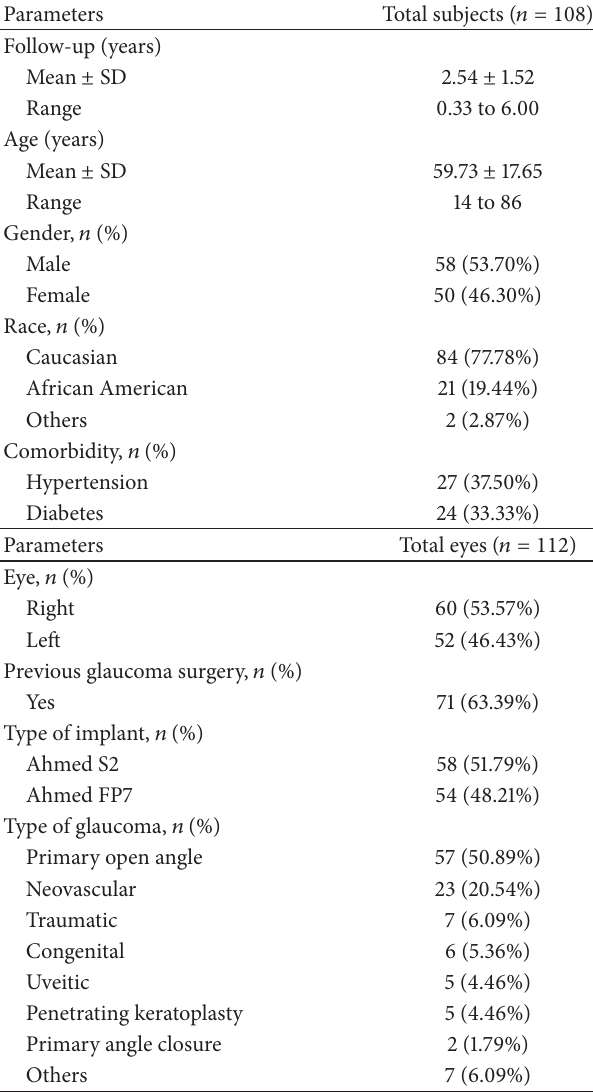
Table 1: Demographic and clinical characteristics of study patients.